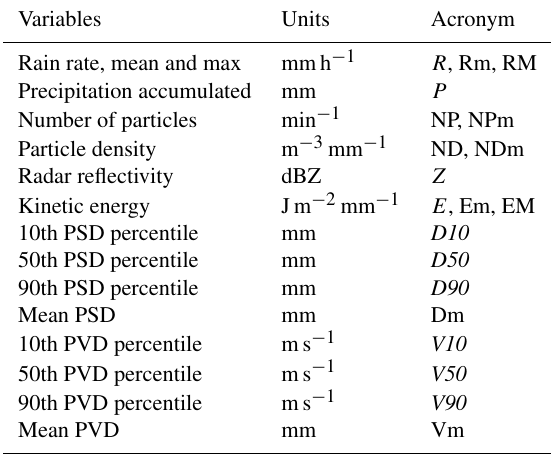
Table 2. Disdrometer evaluated variables. M and m stand for max- imum and mean,